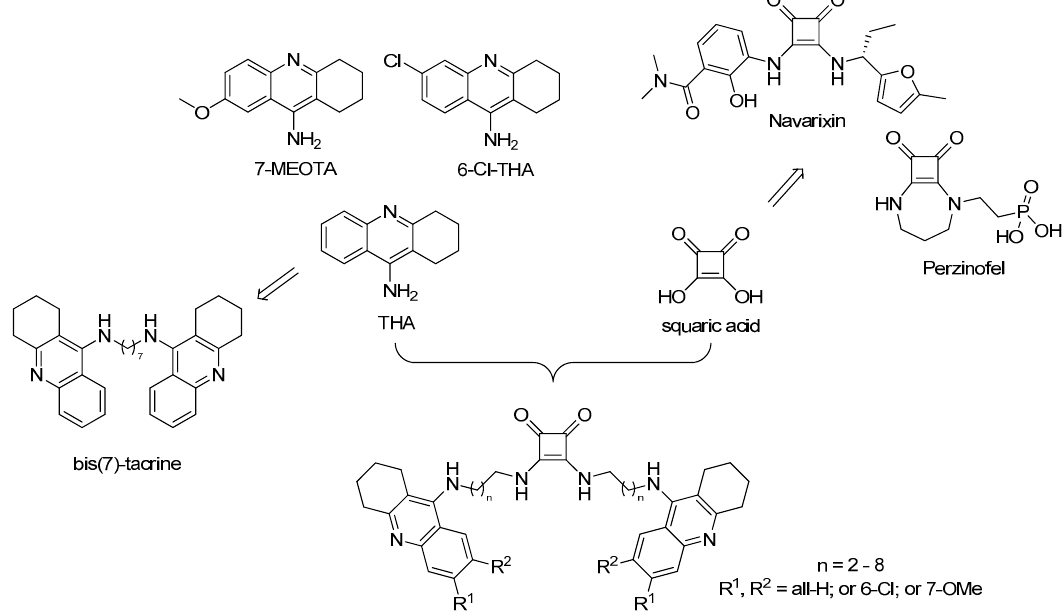
Figure 1. Schematic drawing for the design of tacrine-squaramide homodimers.